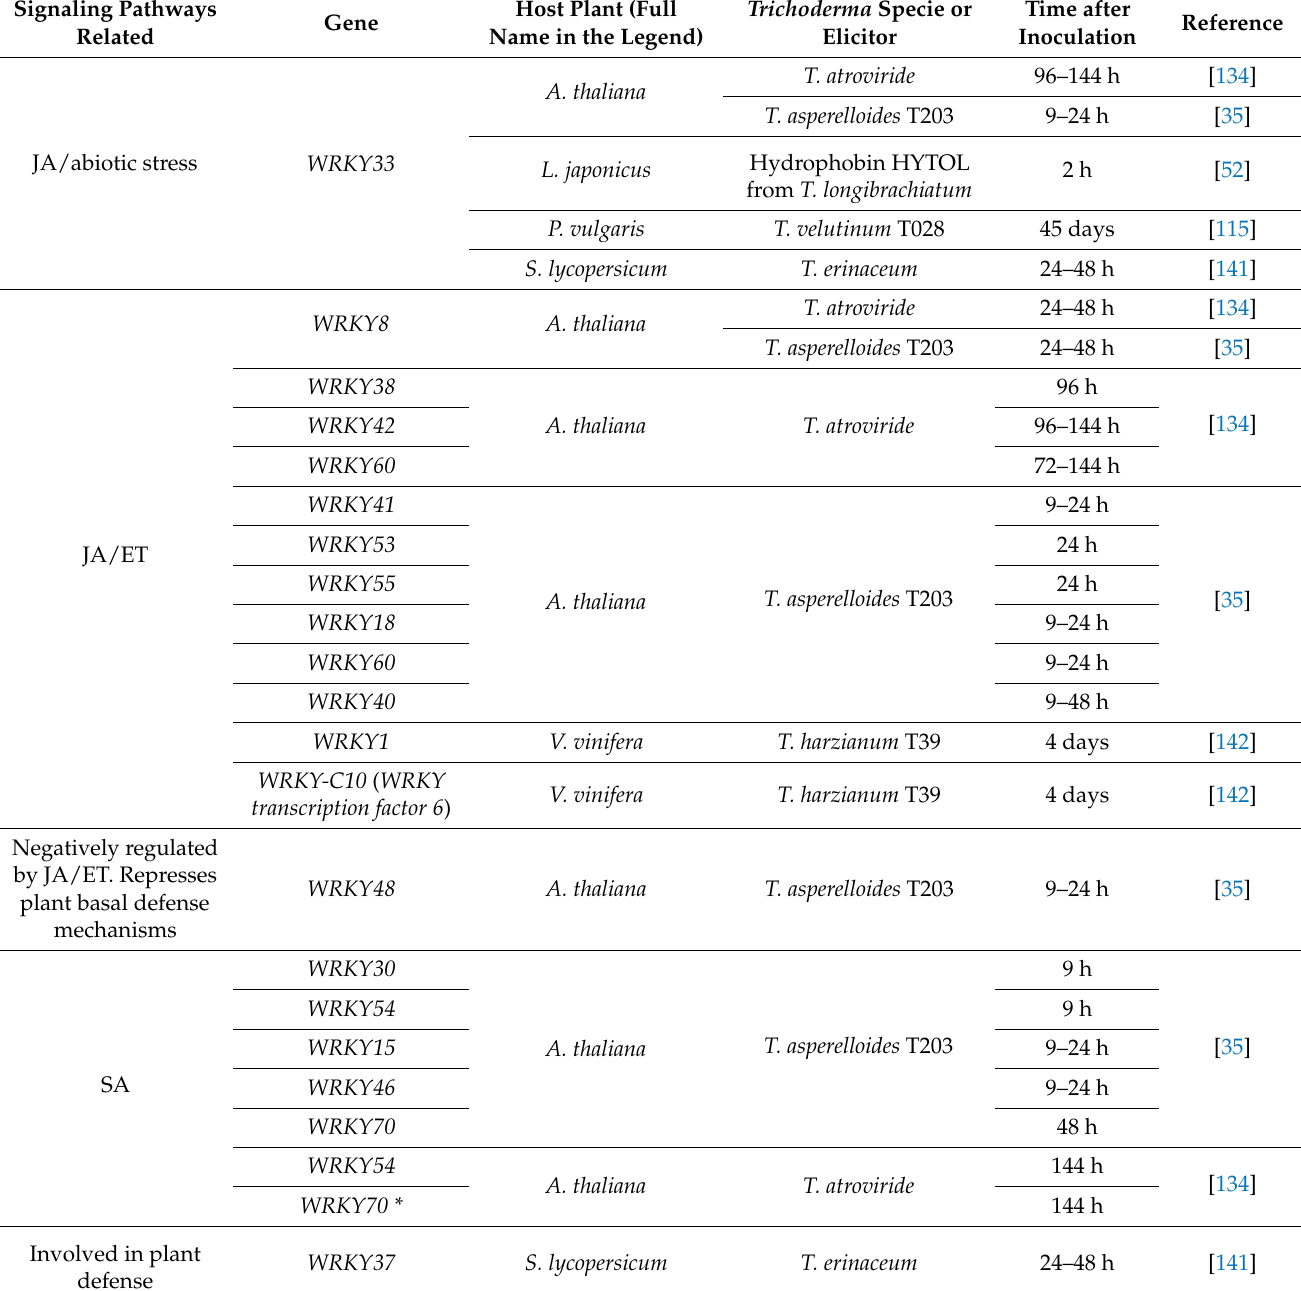
Table 1. Expression of WRKY genes up-regulated by Trichoderma